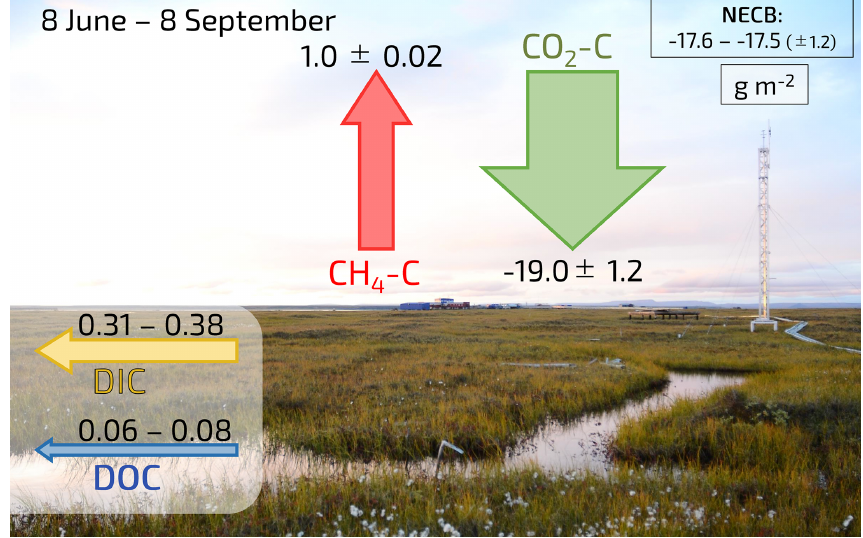
Figure 3. Schematic illustration of all four cumulative flux components of the NECB (DIC, DOC, CH 4 -C, and CO 2 -C) in gm − 2 during the study period in 2014. The NECB is shown in the top right corner. Uncertainties from systematic errors are denoted with an en dash (–), while uncertainties from random errors are indicated with the plus–minus symbol ( ± ). The picture in the background was taken on 30 August 2016 and provided by Jean-Louis